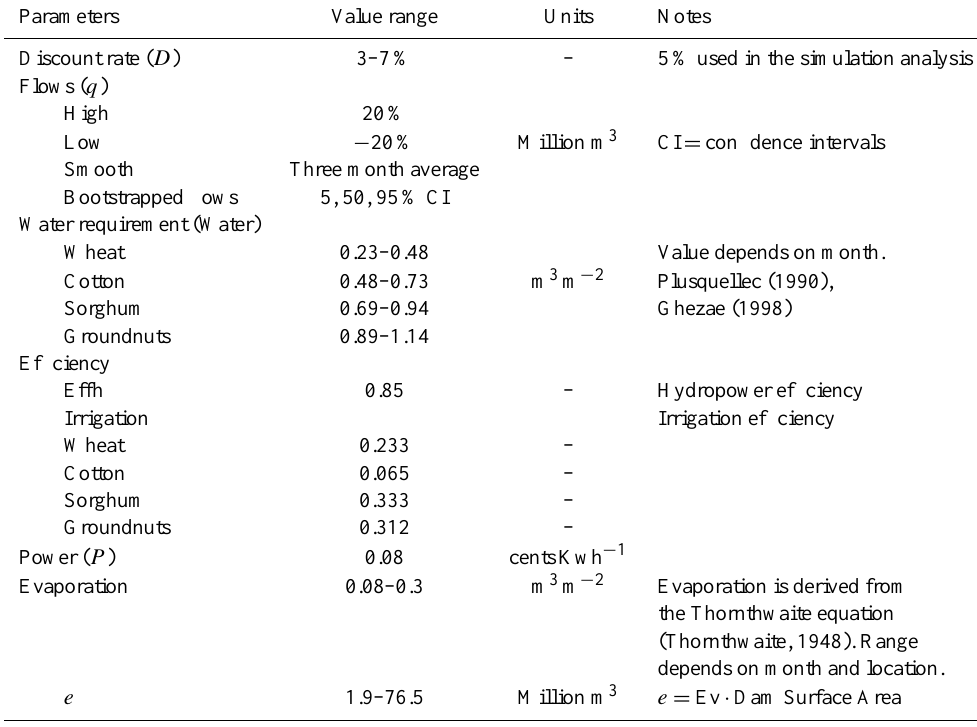
Table 1. SHOM parameters.